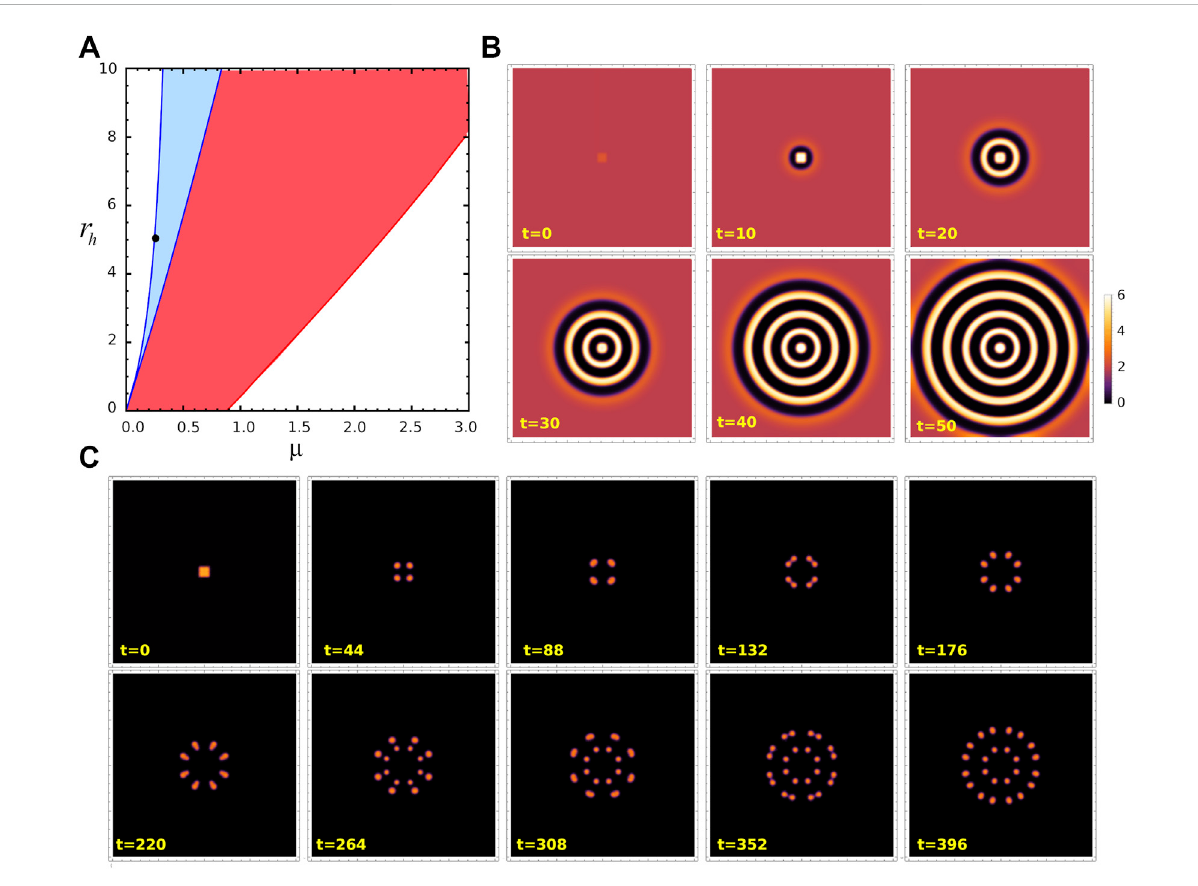
FIGURE 7 Turingpatternsin2D. (A) ParameterregionwherestableTuringpatterns(blue)andunstableTuringpatterns(red)canbefound,for r a =10.Black dot corresponds to ( μ , r a , r h )=(0.25,10,5)= P 1 , in the stable Turing pattern region. (B) Snapshots from space-temporal 2D simulations showing activatorconcentrationpatternforparametersvalue P 1 atdifferenttime t .Thesepanelscorrespondstothecasewhen fi xedpoint S 2 isperturbedbya smallperturbationatthecentreofthe fi eld. (C) Snapshotsfromspace-temporal2Dsimulationsshowing a forthesameparametersvalue,when uniform distribution associated to fi xed point S 1 is perturbed by the same perturbation. The region considered is 40×40 with periodic conditions. Animated Movies associated to these simulations are available as Supplementary Movies S1 and